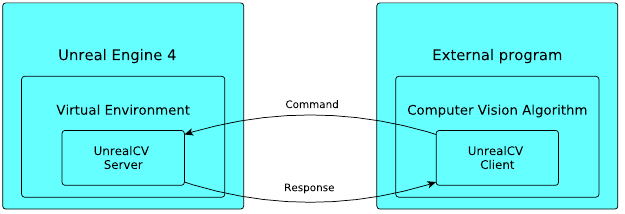
Figure 2. via UnrealCV.